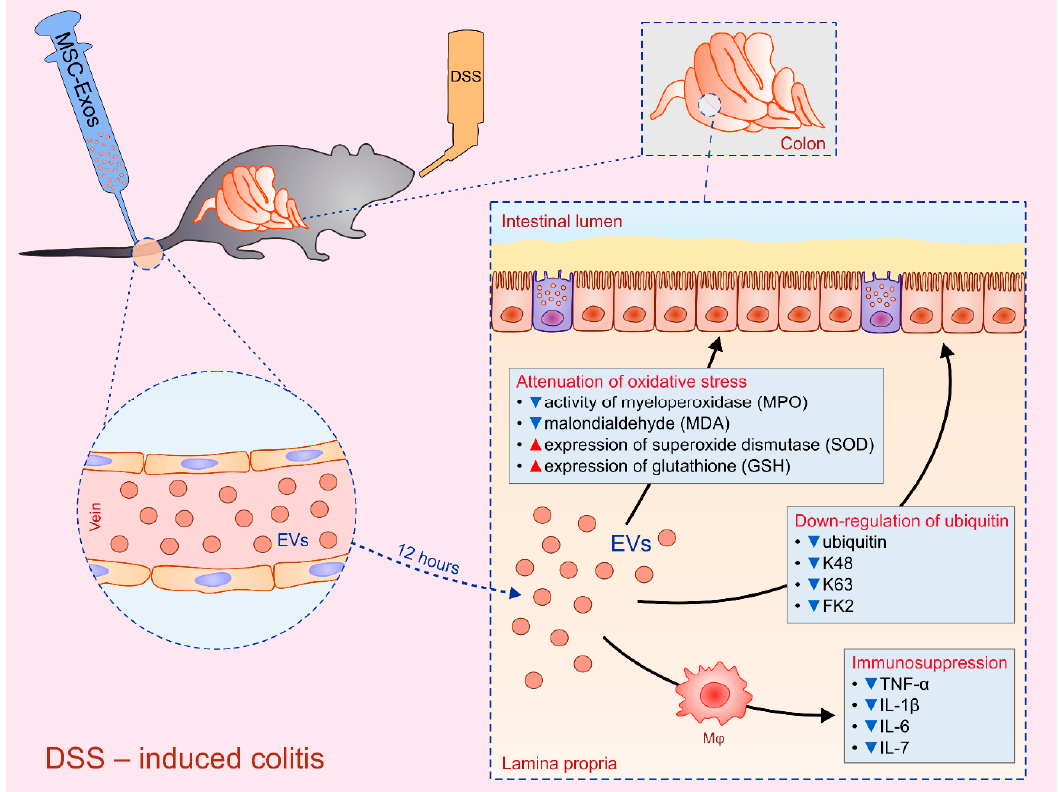
Figure 3. Therapeutic effects of MSC-derived secretome in attenuation of experimental colitis. Administration of MSC-sourced extracellular vesicles (EVs), including MSC-derived exosomes (Exos), efficiently alleviated dextran sodium sulphate (DSS)-induced colitis. Intravenous injection of MSC-EVs significantly decreased activity of myeloperoxidase (MPO), malondialdehyde (MDA) and notably increased expression of superoxide dismutase (SOD) and glutathione (GSH) in inflamed colons, indicating that modulation of anti-oxidant / oxidant balance in inflamed gut had important role for MSC-EVs-based therapeutic e ff ects. Down-regulation of ubiquitin and ubiquitin-associated molecules (K48, K63 and FK2) in inflamed gut were also responsible for MSC-Exo-based attenuation of colitis. Additionally, MSC-derived secretome attenuated production of inflammatory cytokines (TNF- α , IL-1 β , IL-6, IL-7) in colon macrophages resulting in alleviation of on-going